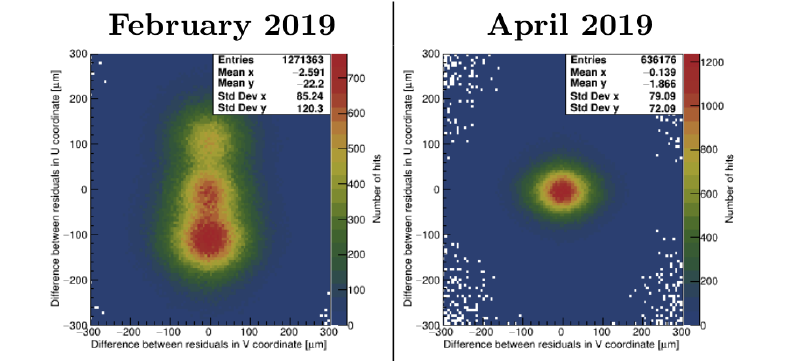
Figure 2: Overlap residual distributions from all VXD sensors in 2019 cosmic data before fixing SVD sensor pitch (left) and after